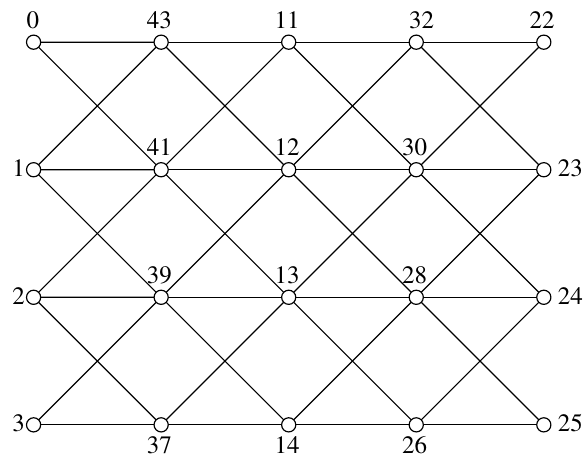
Figure 3: 4-divisible α -labeling of S